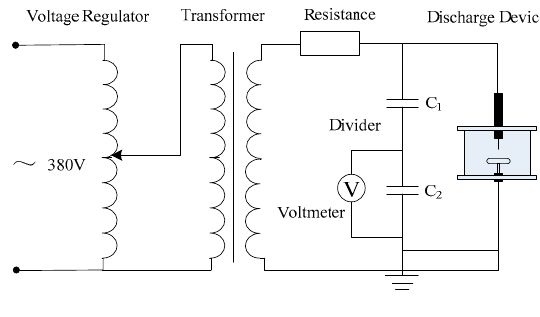
Figure 1. Experiment circuit.